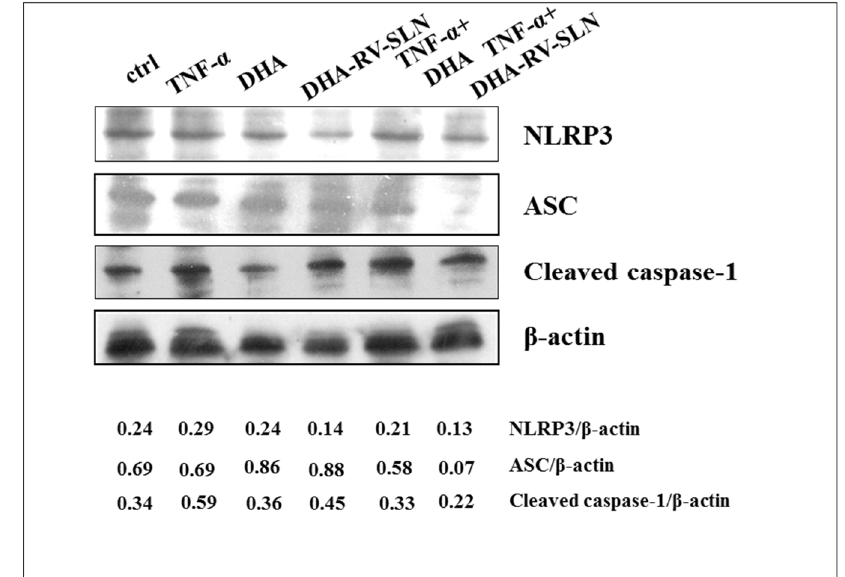
Figure 7. Effect of free DHA and DHA-RV-SLNs on the expression of NLRP3 inflammasome Figure7. E ff ectoffreeDHAandDHA-RV-SLNsontheexpressionofNLRP3inflammasomecomponents. components. HaCaT cells were treated with free DHA (30 μ M) and DHA-RV-SLNs (30 μ M) in the HaCaT cells were treated with free DHA (30 µ M) and DHA-RV-SLNs (30 µ M) in the absence or in the absence or in the presence of TNF- α (50 ng/mL) for 24 h, and the expression of NLRP3, ASC, and presence of TNF- α (50 ng / mL) for 24 h, and the expression of NLRP3, ASC, and cleaved caspase 1 was cleaved caspase 1 was evaluated by Western blotting. A representative Western blot analysis of two evaluated by Western blotting. A representative Western blot analysis of two di ff erent experiments different experiments is shown. The data represent the ratios between the densitometric values of is shown. The data represent the ratios between the densitometric values of the proteins and that of β -actin as a loading the proteins and that of β -actin as a loading control.